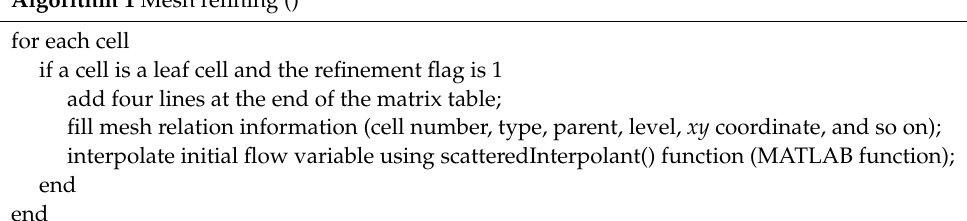
Algorithm 1 Mesh refining ()